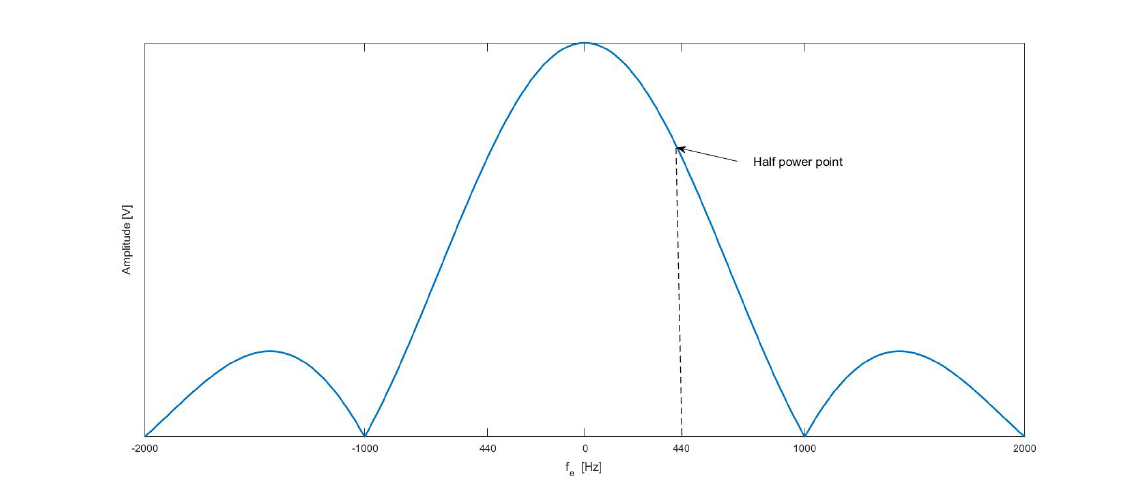
Figure 5. Incoherent integral losses due to frequency